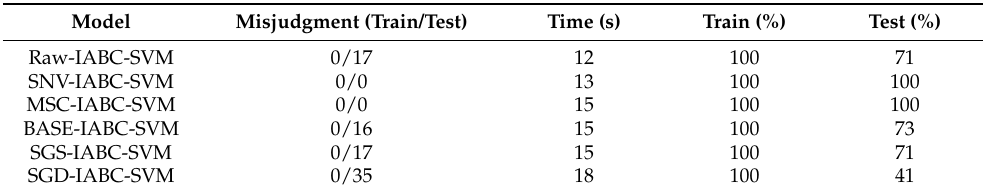
Table 3. The IABC-SVM classification models established by the original Ranman spectra and the Ranman spectra after after five different kinds of pretreatments.